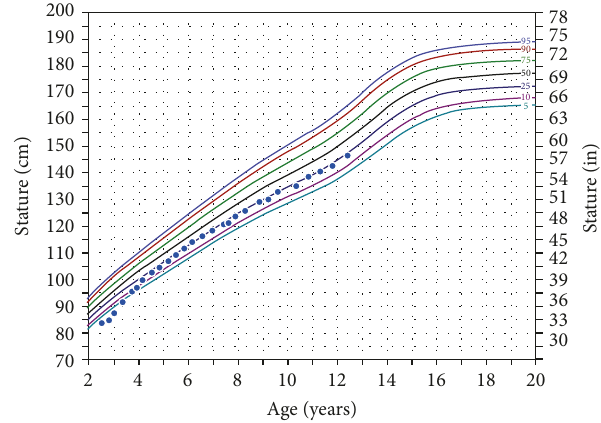
Figure 2: Height growth chart for Case 2 .